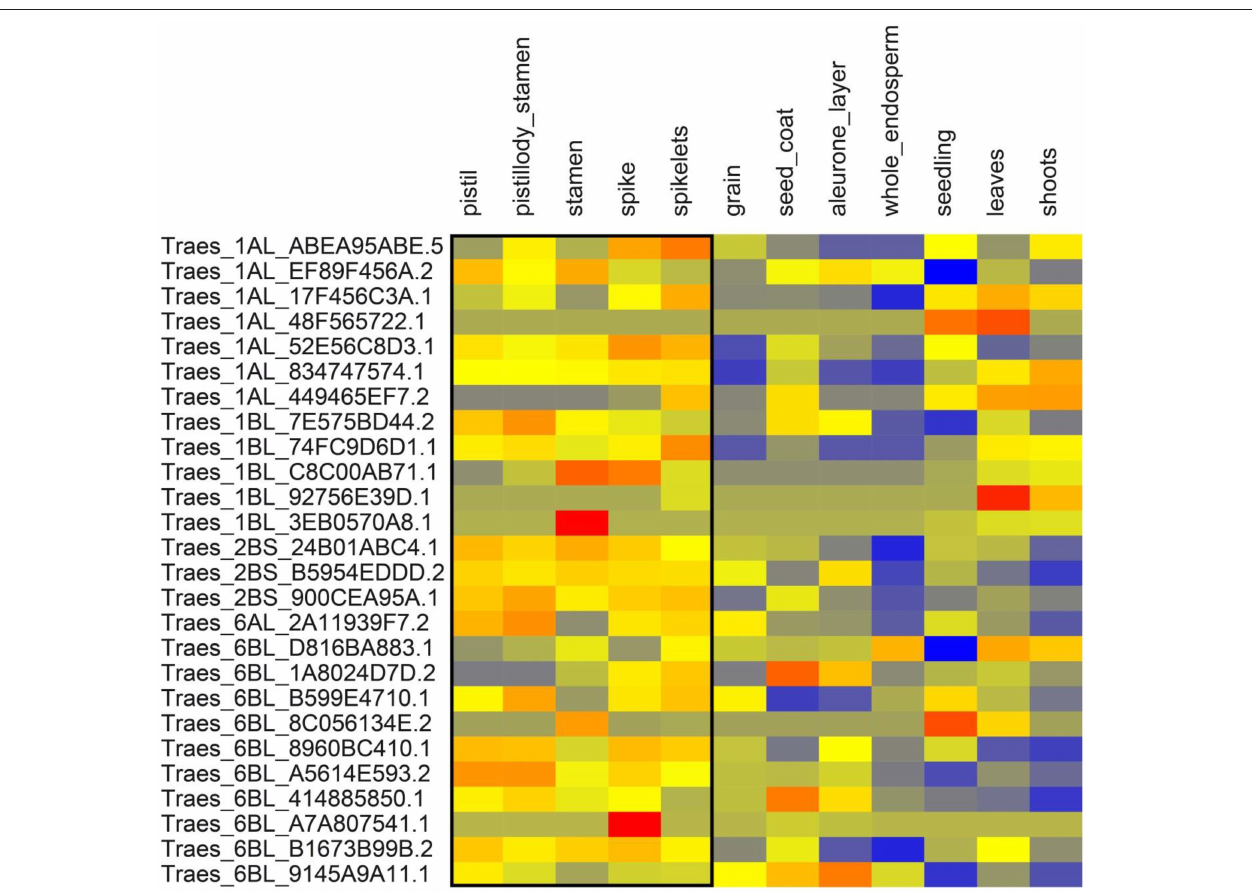
FIGURE 7 | Expression of genes from winter wheat panel in above ground tissues. Expression values are given at log2 scale of transcripts per million (tpm): red, high expression; yellow, moderate expression; blue, low expression. Each individual gene (transcript_ID) is represented as horizontal row and different tissues are described in vertical columns. Tissues from pistil to spikelets show higher expression values for most genes compared to other tissues. Gene expression data were obtained from